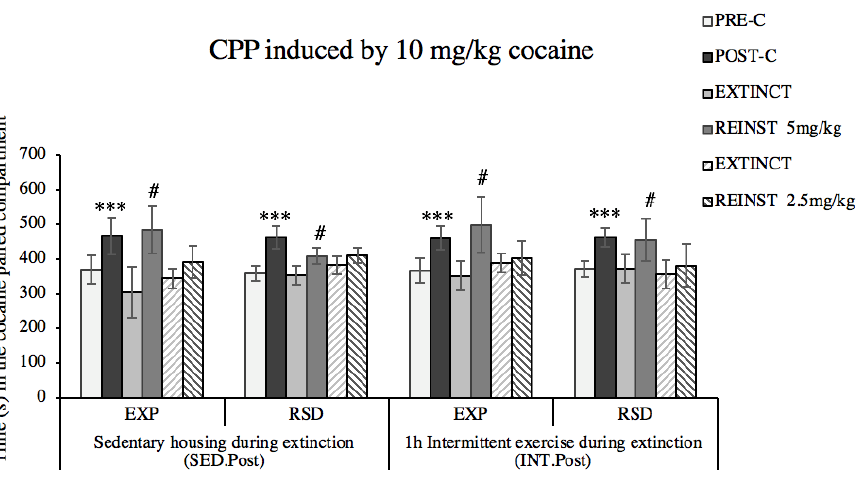
Figure 8. A dose of 10 mg/kg of cocaine induced CPP in all experimental groups. Animals were randomly assigned to the following groups according to their social-stress history and the physical- activity condition during extinction of drug-associated memories: non-stressed animals with seden- tary activity during extinction (EXP–SED.Post) or with a regiment of intermittent exercise (EXP– INT.Post); socially defeated animals with sedentary activity during extinction (RSD–SED.Post) or with a regiment of intermittent exercise (RSD–INT.Post). The bars represent the time (s) spent in the drug-paired compartment before conditioning sessions in the PRE-C test (white bars), and after conditioning sessions in the POST-C test (black bars), in the first extinction sessions (EXTINCT, light gray bars), and in the reinstatement with 5 mg/kg cocaine (REINST 5 mg/kg cocaine, dark gray bars), in the second extinction sessions (EXTINCT, light gray striped bars), and in the reinstatement with 2.5 mg/kg cocaine (REINST 2.5 mg/kg cocaine, dark gray striped bars). Data are presented as mean values ± SEM. Bonferroni’s test # p < 0.05; *** p < 0.001 significant difference in the time spent in the drug-paired compartment vs. corresponding Pre-C.